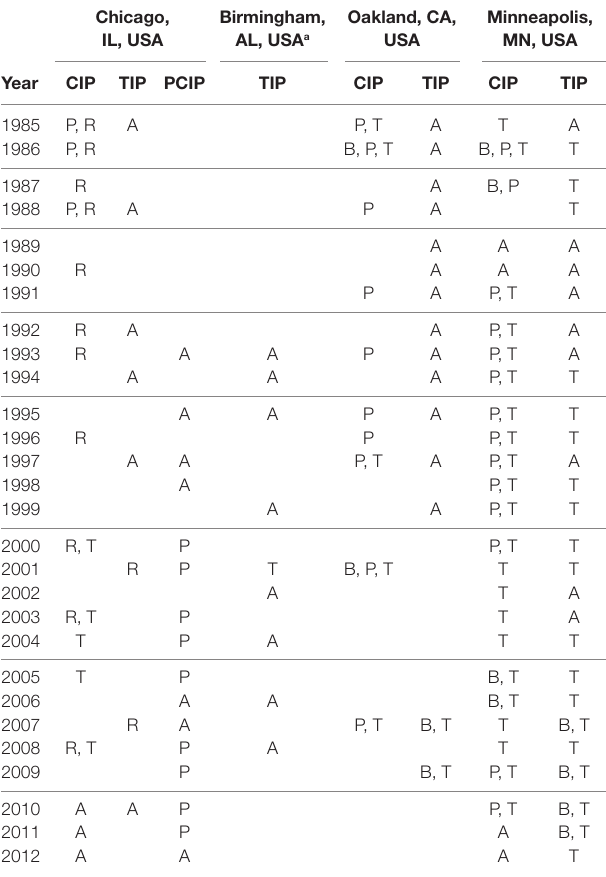
tABLe 4 | Availability of CIP, PCIP, and tIP by year for verification of spatial elements and feature